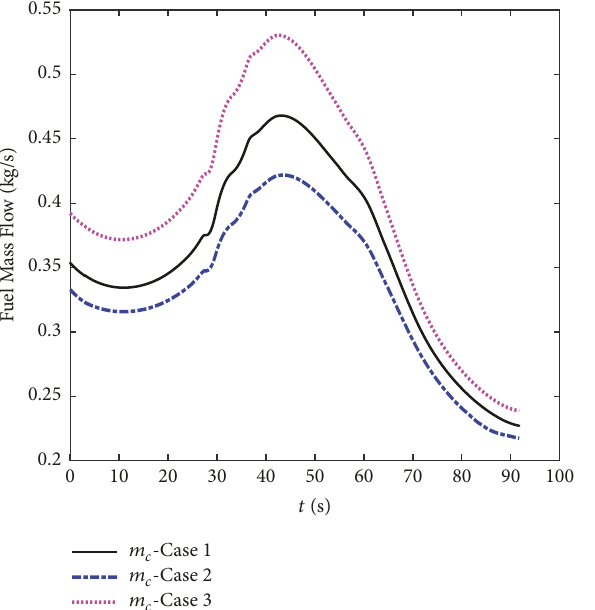
Figure 11: Estimation error of the total disturbances.